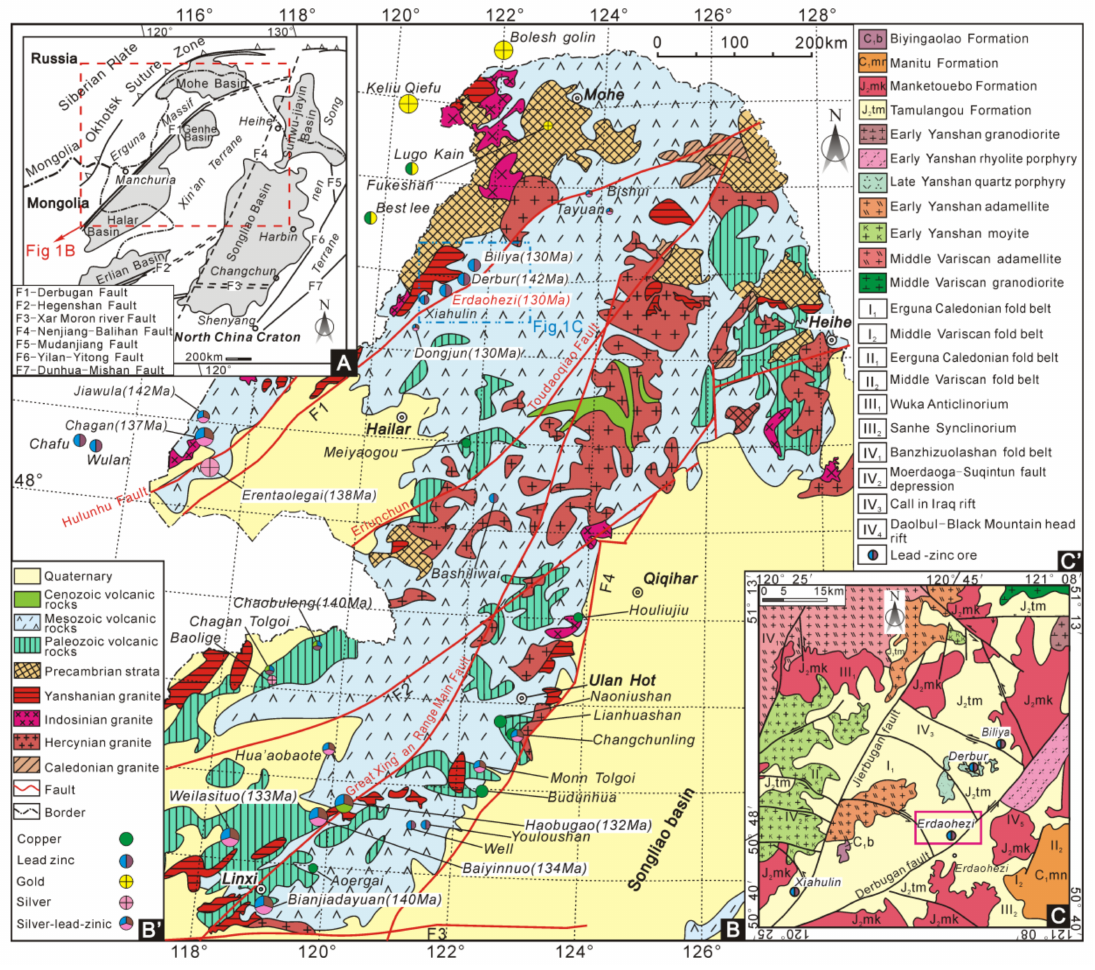
Figure 1. ( A ) Regional geological structure map of Northeast China [21]. ( B ) Geologic map and Pb–Zn deposits in the region [22]. ( C ) Regional geological map of the study area